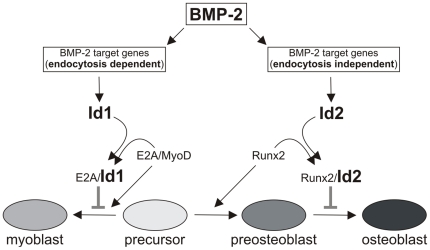
Hypothetical model.Id1 prevents myogenic differentiation by interfering with the transcriptional activity of E2A/MyoD complexes [16]. During early stages of osteoblast differentiation, Runx2 is expressed. Expression levels of Runx2 need to be tightly controlled during later stages of differentiation, as Runx2 overexpression prevents late osteoblast differentiation [52]. In addition, it was demonstrated that Id2 prevents Runx2 binding to the late osteoblast marker promoter of OCN
[38]. We suggest that differential gene expression regulation reliant on endocytic signal transduction provides an additional mechanism for the cell to regulate differentiation processes.